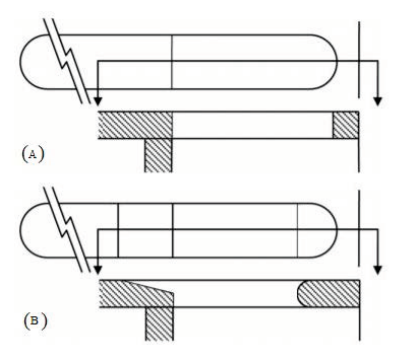
Figure 8. Ventilation slots details ( A ) with square-edged ( B ) tapered [10]. Numerous cavity configurations were tested at the ground level [10]. The cavities were the plane cavity, the original vented cavity with square edge slots, the vented cavity with tapered slots on all surface areas, and the same cavity with undesirable slots covered. For both earlier settings, the standard pressure measurements were made for the ideal cavity and a much deeper cavity. The pressure measurements were undertaken for various cavity depths in the two ventilated cavities with tapered holes. In each case, comparisons were made with the base pressures calculated without a cavity on the quarterback